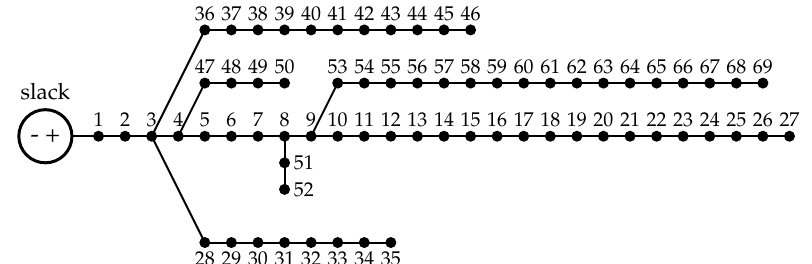
Figure 5. Schematic connection among nodes for the 69-node test